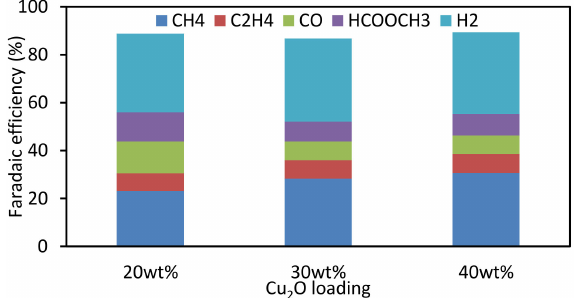
Figure 7. Influence of Cu 2 O loading on the Faradaic efficiencies of products during the electrochemical reduction of CO 2 . Potential: − 1.9 V, catholyte: 0.15 M of NaCl in